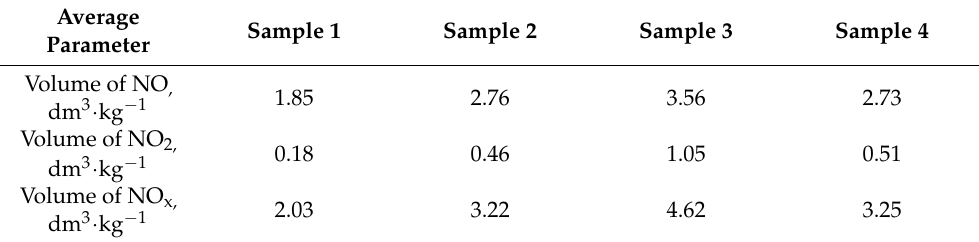
Table 6. Post-blast volume after 10 min, afterburning effect of the non-ideal explosive with a microstructure charcoal enhancer of − 90 µ m